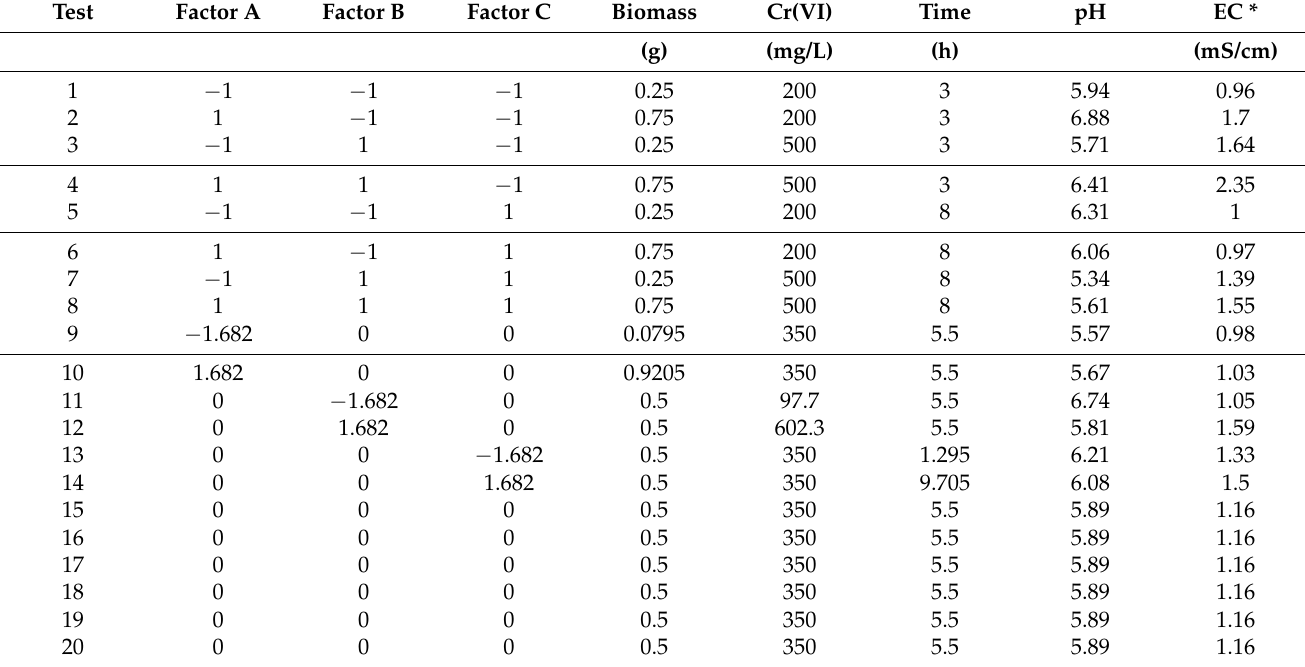
Table 3. The 20 adsorption tests of the central composite experimental design.